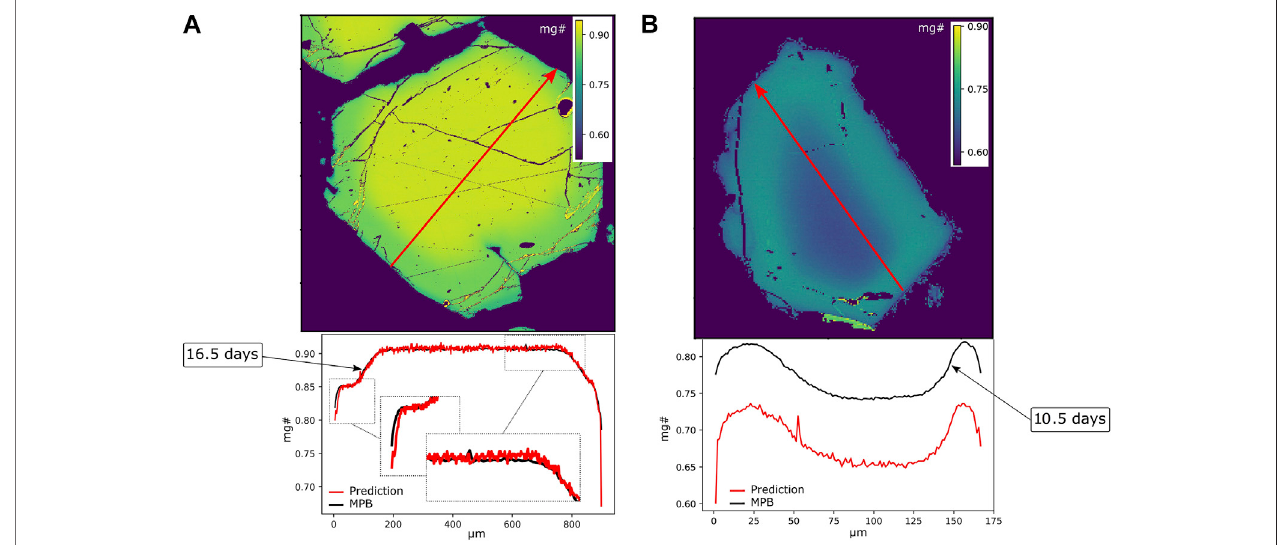
FIGURE8| Panel (A) Compositional2Dmapof mg# inDL-segmentedolivine(VIIcf. Figure1 )predictedfromtheBSEgreylevel.TheimagetileisfromDL-Dataand wasused inDL training. Red and black lines demonstrate predicted and original (EPMA) mg# pro fi les.Diffusion modelling alongthis pro fi le revealsthat Fe-Mg exchange occurred for ~ 16 . 5 days, assuming following boundary conditions: T =1200 C , 1 atm pressure and NNO oxygen buffer, diffusion proceeds along [001] axis (Costa et al., 2008). Panel (B) Compositional 2D map of predicted (from the BSE grey level) mg# in DL-segmented reversely zoned olivine (V cf. Figure 1 ). The image tile is from the session 32 and was not used in DL training. Red and black lines demonstrate predicted and original (EPMA) mg# pro fi les. Diffusion modelling along this pro fi le (its right part)revealedthatFe-Mgexchangeoccurredfor10.5 days,assuming followingboundaryconditions:T=1180C,1atmpressureand NNO oxygenbuffer, diffusion proceeds along [010] axis (Costa et al., 2008). The left part of the pro fi le is strongly distorted and cannot be modelled.